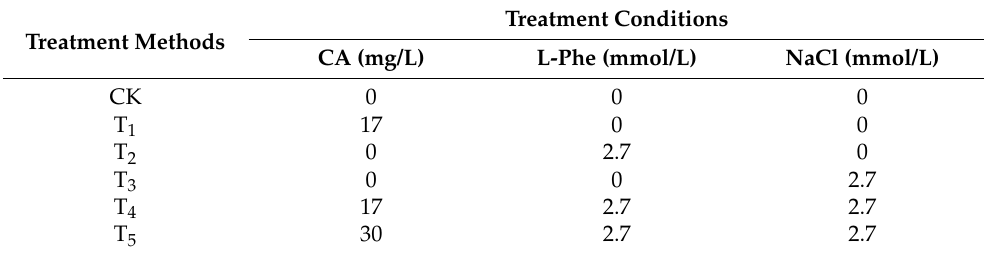
Table 1. Concentration of exogenous additives and germination conditions of TB sprouts. Treatment